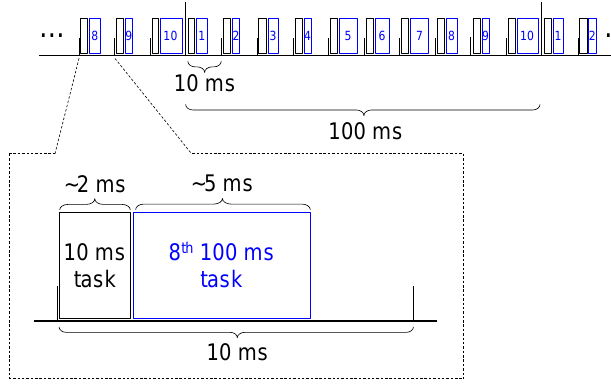
Figure 2. Schematic of the real-time scheduler in the